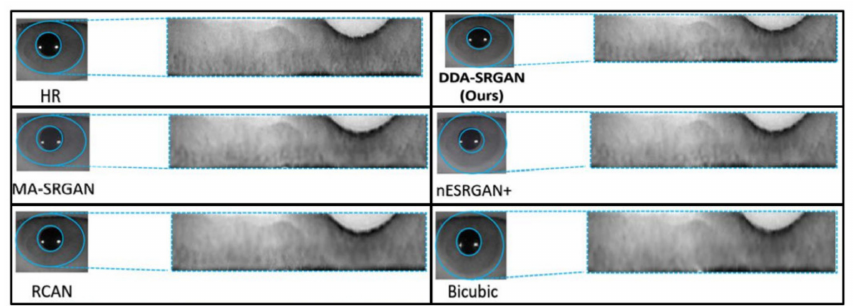
Figure 17. Visual comparison of the super-resolved image of “Rcls489_7” from CASIA dataset.